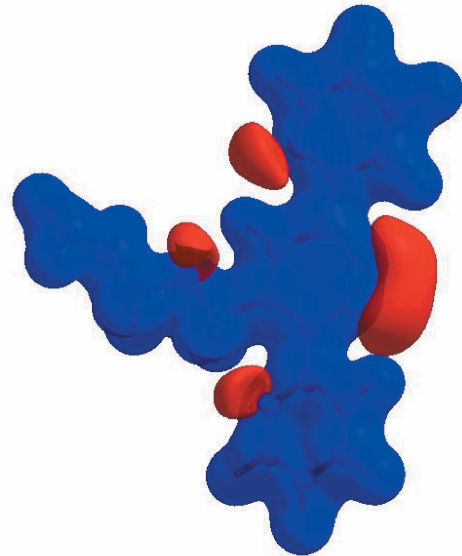
Figure 5 View of the three-dimensional Hirshfeld surface of the title compound plotted over electrostatic potential energy in the range (cid:4) 0.0500 to 0.0500 a.u. using the STO-3 G basis set at the Hartree–Fock level of theory. Hydrogen-bond donors and acceptors are shown as blue and red regions, respectively, around the atoms, corresponding to positive and negative potentials.